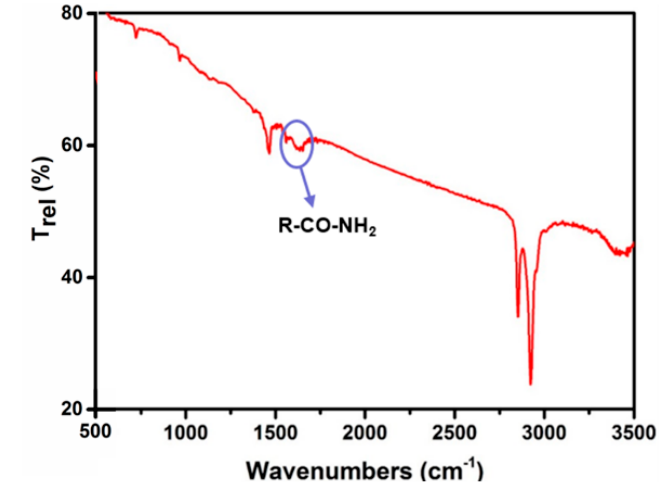
Figure 8. FI-IR spectrum of the final reaction solution.